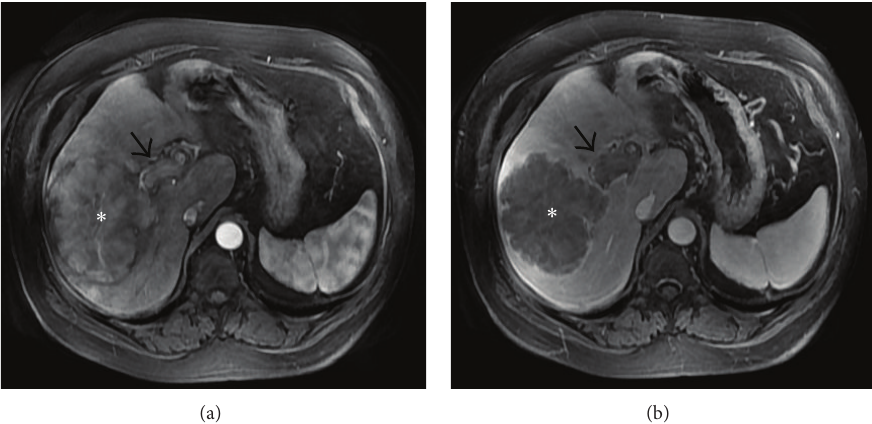
Figure 41: Axial CEMRI images obtained in the arterial (a) and venous (b) phases showing a lobulated lesion showing arterial phase enhancement (asterisk in (a)) with washout of contrast on the venous phase. Associated enhancing right portal vein tumor thrombus (arrows) is